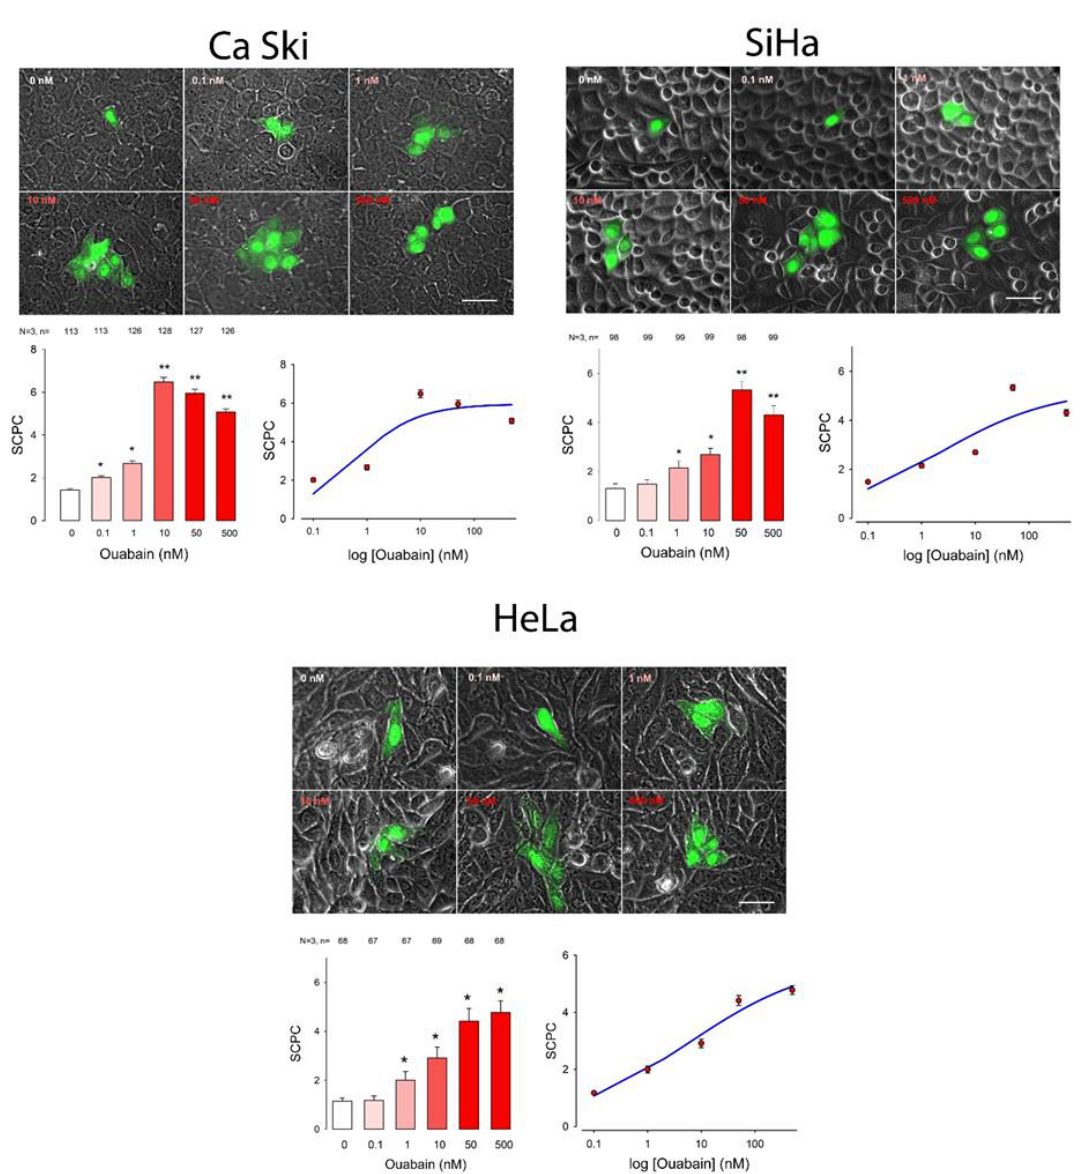
Figure 1. Effect of ouabain on gap junctional intercellular communication (GJIC) of cervico-uterine cancer cell lines (CasKi, SiHa and Hela). Each set shows, in the top part: representative images comparing the number of stained cell per cluster (SCPC) after one of them had been injected with Lucifer Yellow, from monolayers that were either untreated (0 nM) or treated for one hour with ouabain in the concentration indicated (nM). In the bottom part: ( Left ) Histogram showing the average ( ± SE) SCPC in monolayers of confluent cells that were treated with ouabain, for one hour, in the concentrations indicated at the bottom of the bars. At the top of each bar the number of repeats after three independent trials is shown. Asterisks indicate a statistically significant difference compared to the control group, (Dunn’s method), * indicates p < 0.05, ** indicates p < 0.001. Scale bar length = 100 µ M. ( Right ) A semi-log plot shows mSCPC ± SE (red) and the curve (blue) resulting after fitting data to a logistic